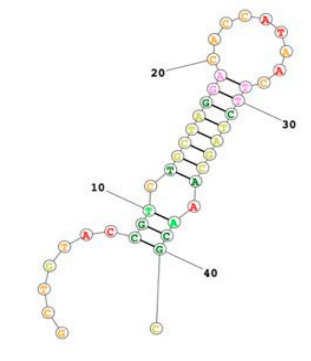
Figure 1. The secondary structure of 7R aptamer analysis by